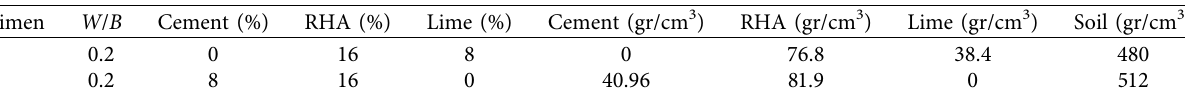
Table 2: Mix design of soil stabilizer and pozzolan values used in the experimental